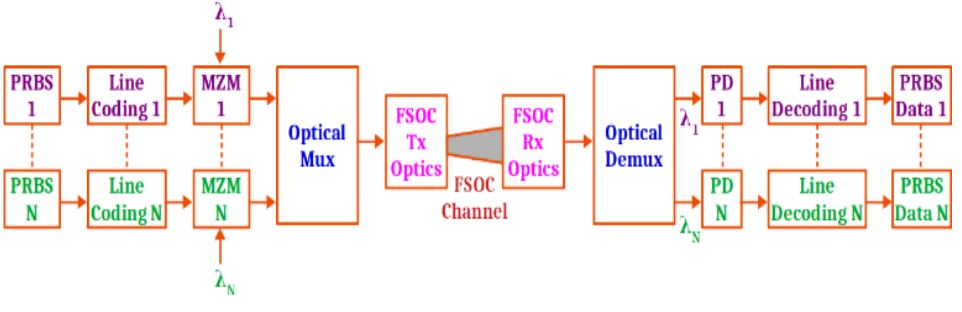
Figure 22. Schematic of WDM in FSOC system.